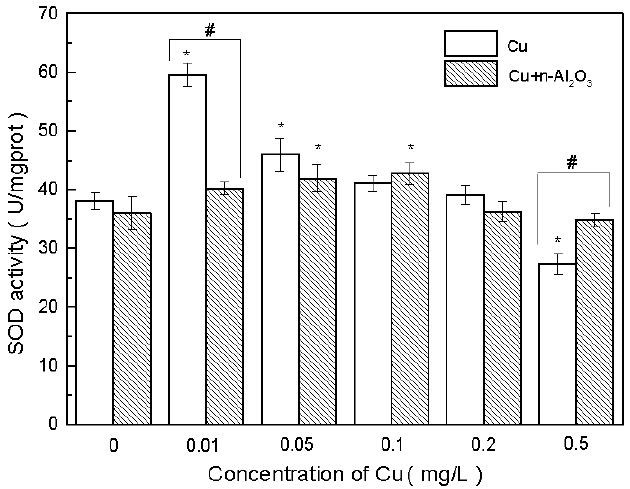
Figure 3. Superoxide dismutase (SOD) activities in S. obliquus exposed to copper and copper/nano-Al 2 O 3 systems at different concentrations of copper after 72 h. Data are mean ± SD ( n = 3). Asterisks indicate the significance of differences ( p < 0.05) between the control and the exposed treatments. Pound signs indicate the significance of differences ( p < 0.05) between copper system and copper/nano-Al 2 O 3 system at the same concentration of copper.